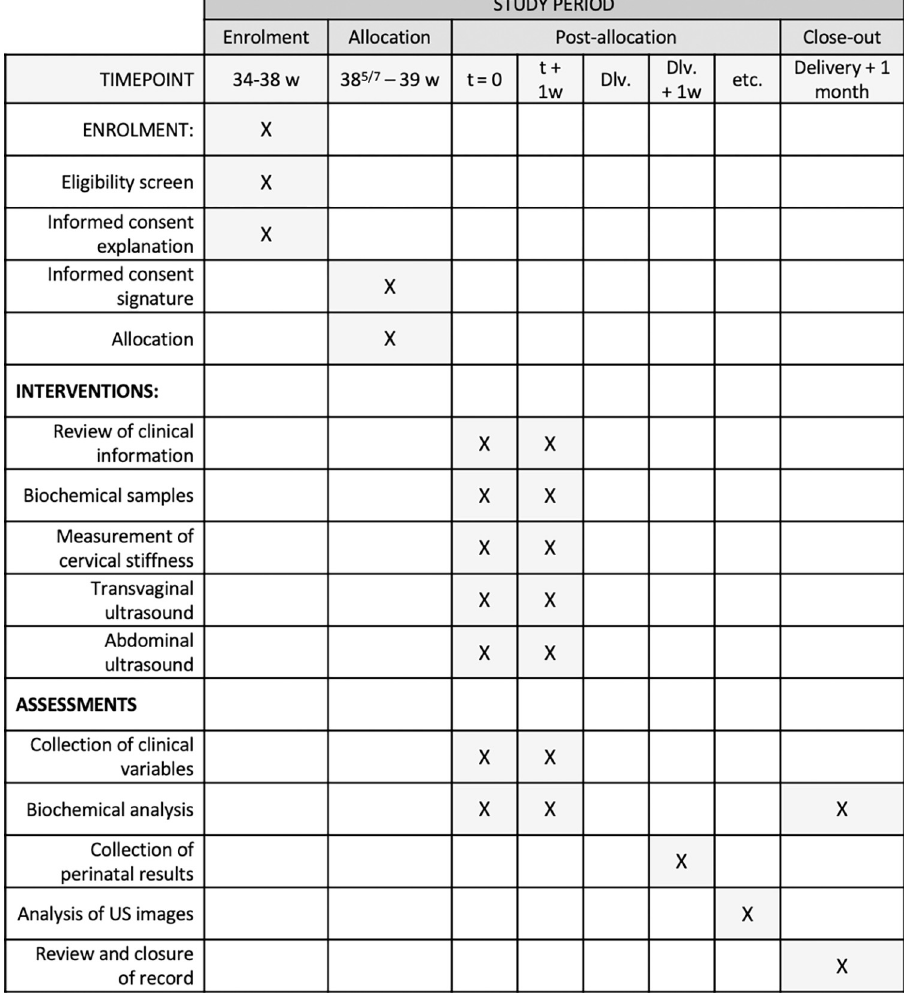
PLOS ONE | https://doi.org/10.1371/journal.pone.0271065 July 13,